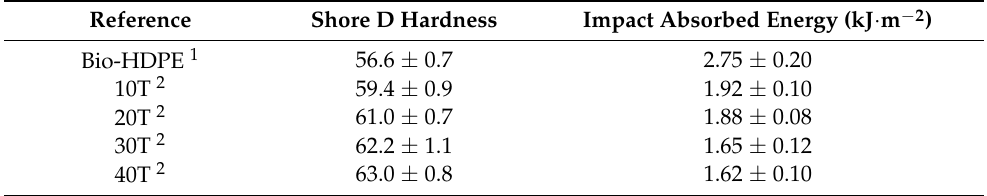
Table 4. Effect of weight percentage of treated chia seed flour with APS on Shore D Hardness and impact absorbed energy.